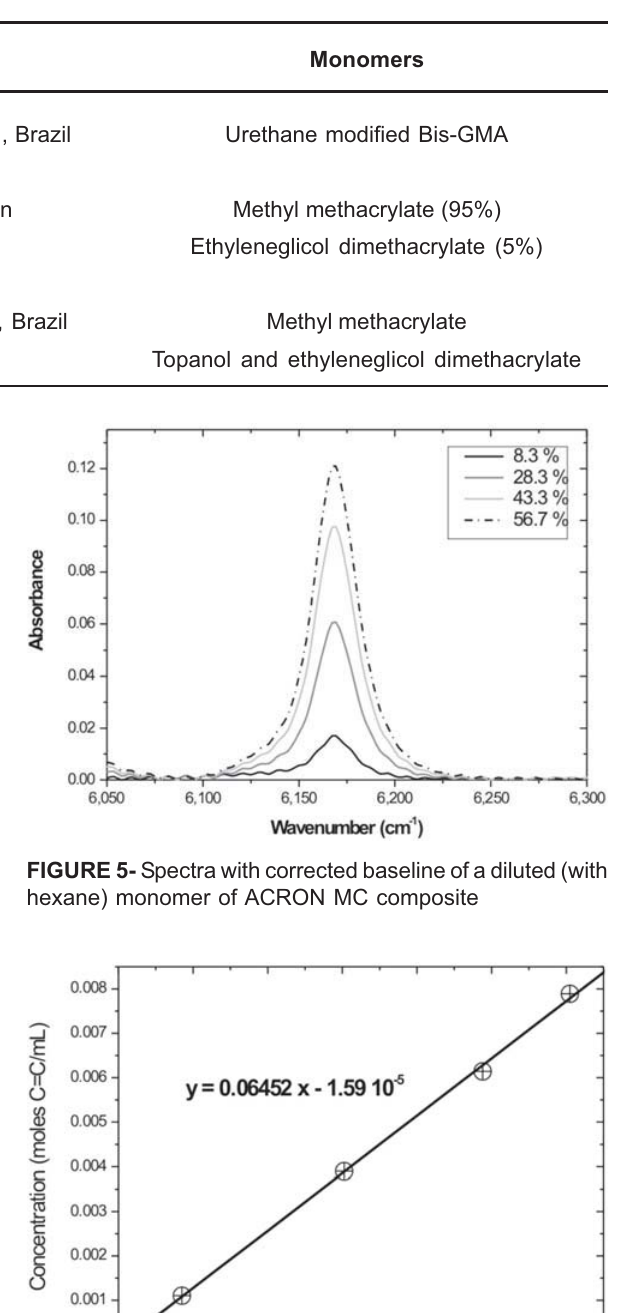
TABLE 1- Information about the composites used in this study